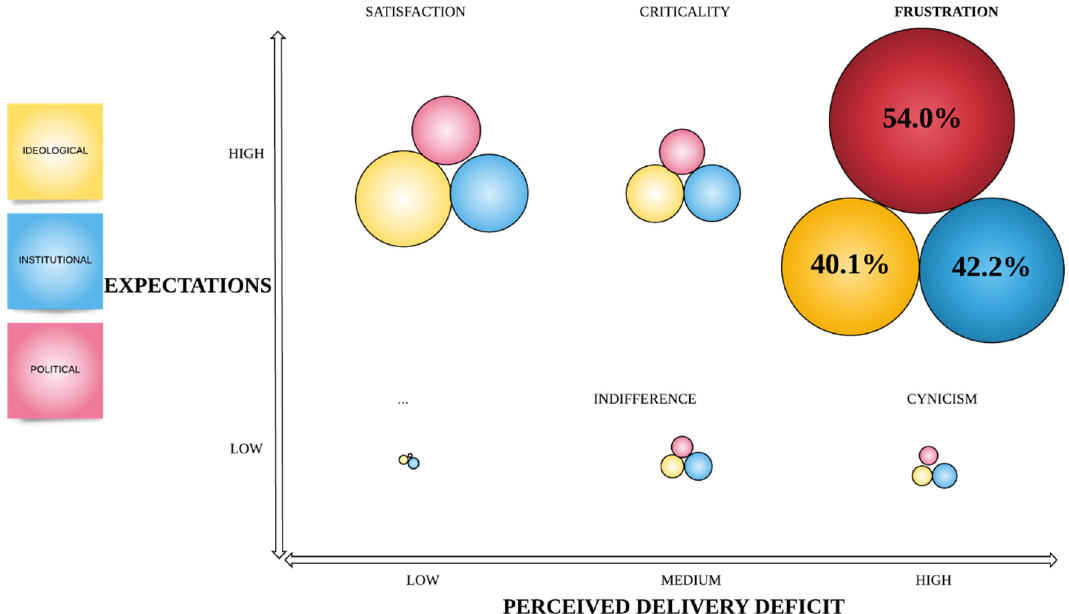
Figure 1. Distribution of democratic frustration and related pathologies by dimension.